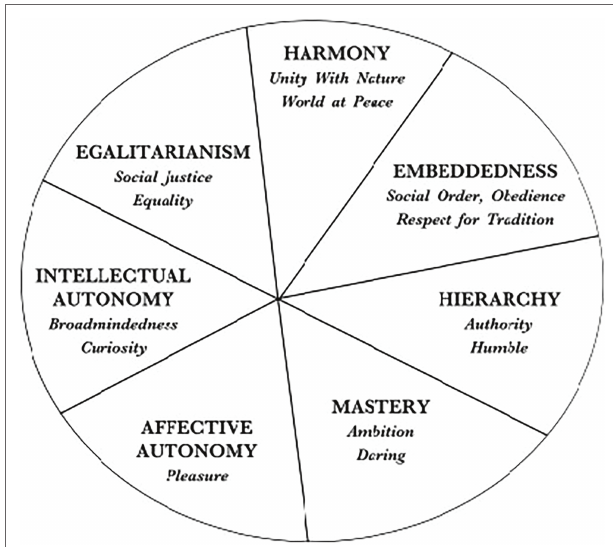
FIGURE 2 | Structure of Culture-Level Value Types. This figure represents the theoretical model of relations among ten types of value at the cultural level. From Schwartz (2006). The figure has been used with the permission of the author.